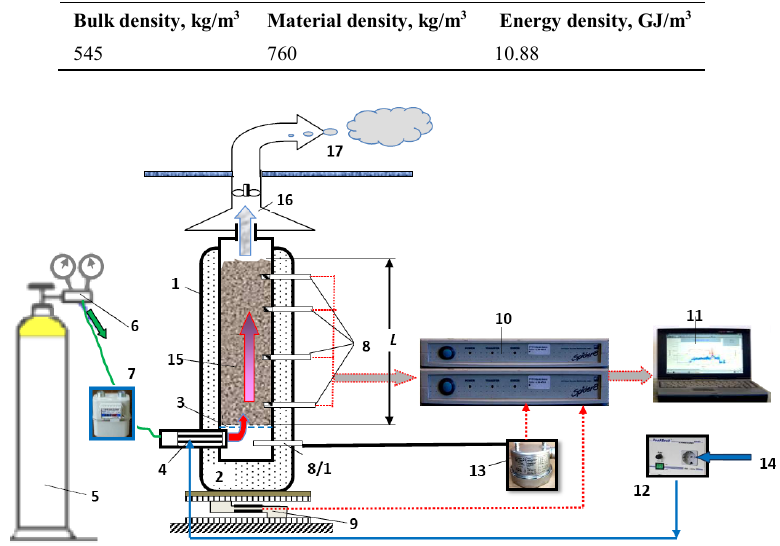
Fig. 1. Schematic diagram of the pyrolysis unit (1 – main body, 2 – insulator, 3 – reactor, 4 – heating element, 5 – N 2 cylinder, 6 – pressure valve, 7 – gas meter, 8 – temperature sensors, 8/1 – pressure probe, 9 – strain gauge, 10 – data logger, 11 – computer, 12 – heating unit, 13 – pressure sensor for reactor, 14 – electrical relay, 15 – feedstock, 16 – chimney, 17 – exhaust